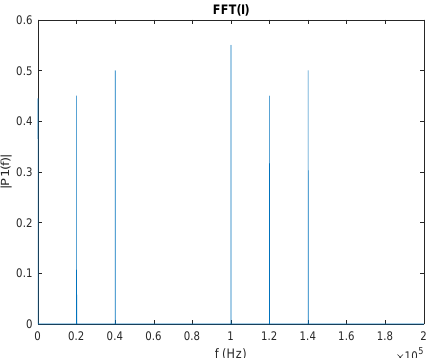
Figure 6. Example of three emitters using FDMA showing the I ( t ) signal in the frequency